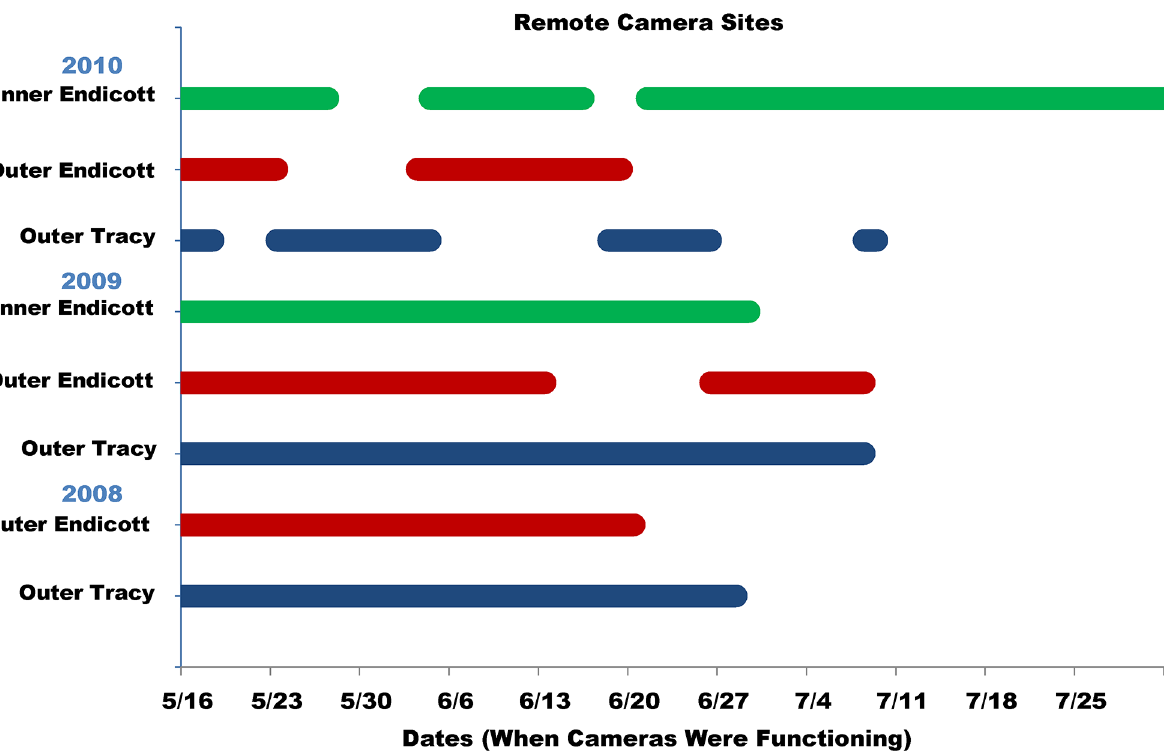
Fig 2. Dates of operation for time-lapse cameras. Cameras were used to detect vessel presence and assess environmental variables such as weather conditions and ice coverage. Horizontal bars indicate the range of dates (color-coded by camera site) that each time-lapse camera was functional at each remote monitoring station throughout the years of the